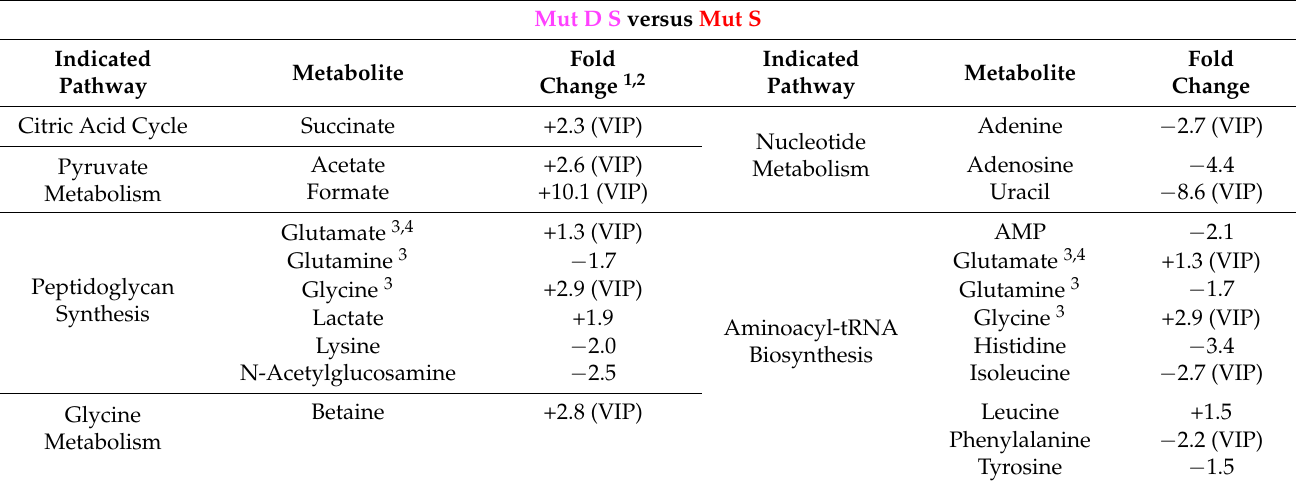
Table 9. Fold change of statistically significant metabolites in their corresponding metabolic pathways for the stationary phase of DABCOMD-challenged mutant versus unchallenged mutant.